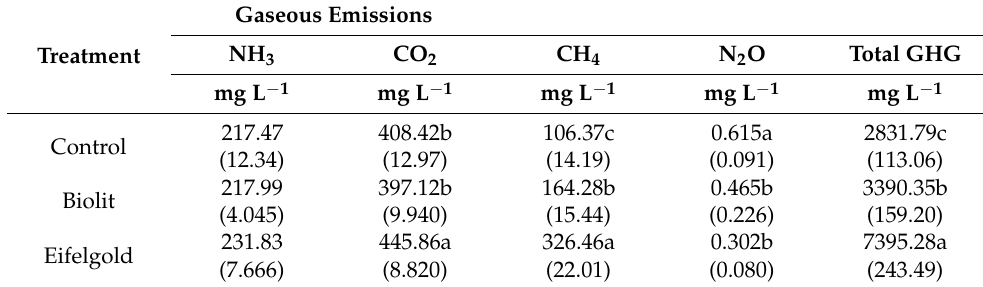
Figure 2. ( a ) Average ammonia (NH 3 ), ( b ) methane (CH 4 ), ( c ) nitrous oxide (N 2 O) and ( d ) carbon dioxide (CO 2 ) emissions of the control slurry and the slurry mixed with the rock powders ‘Biolit’ and ‘Eifelgold’. Temperature values are the median degrees Celsius during each measurement period (3 h) in the barn. The red bar indicates the formation of floating crusts on the slurry surface for the control slurry and to a lesser extent on the ‘Biolit’ slurry from day 38 onwards. Vertical bars represent standard deviation of the mean (n = 4). Table 3. Summary of cumulative gaseous losses from the control slurry and from the slurry with additions of the two rock powders ‘Biolit’ and ‘Eifelgold’ expressed as mg gas per liter cattle slurry after 46 days. Total GHG emissions are CO 2 plus the CO 2 -equivalents of CH 4 and N 2 0. (n = 4, values in parentheses are standard errors. Treatment means with different letters are significantly different to each other at p < 0.05).